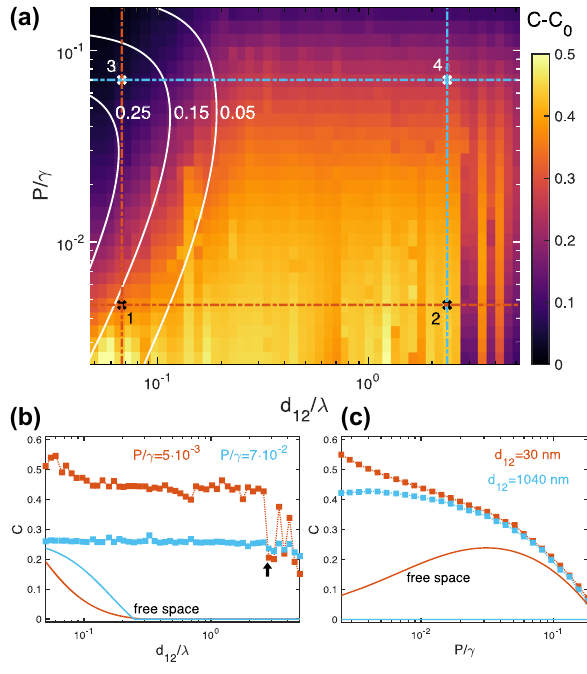
Figure 2: Concurrence as a function of distance and pumping strength. (a) Entanglement generation efficiency, C − C inter-emitter distance and pumping rate for 50 × 27 = 1350 ID cloaks. White solid lines correspond to QE–QE systems yielding three different values of the free-space concurrence, C horizontal lines indicate the configurations considered in the panels below. (b) Cloak-induced (square dots) and free-space (solid lines) concurrences versus inter-emitter distance for low (orange) and high (blue) pumping. (c) Same as (b) but versus pumping strength and for short (orange) and long (blue) inter-emitter